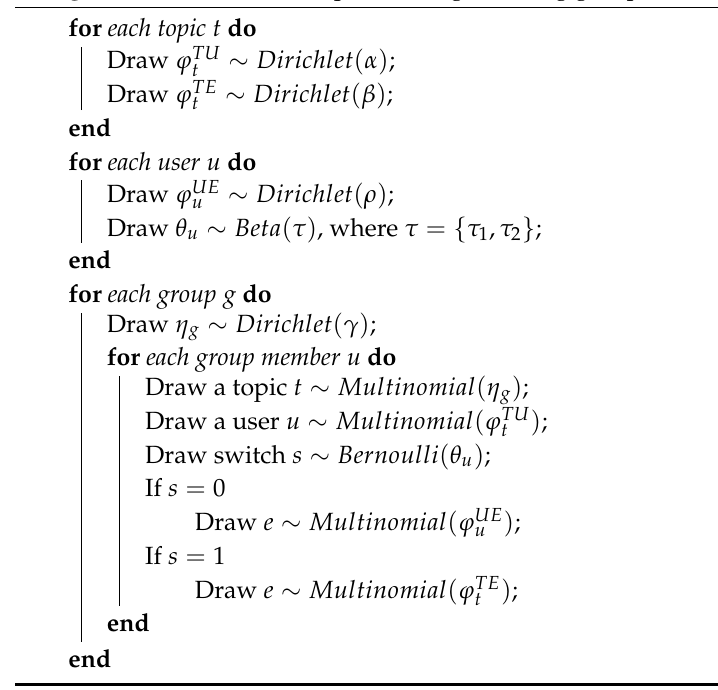
Algorithm 1: Probabilistic process of generating group events in